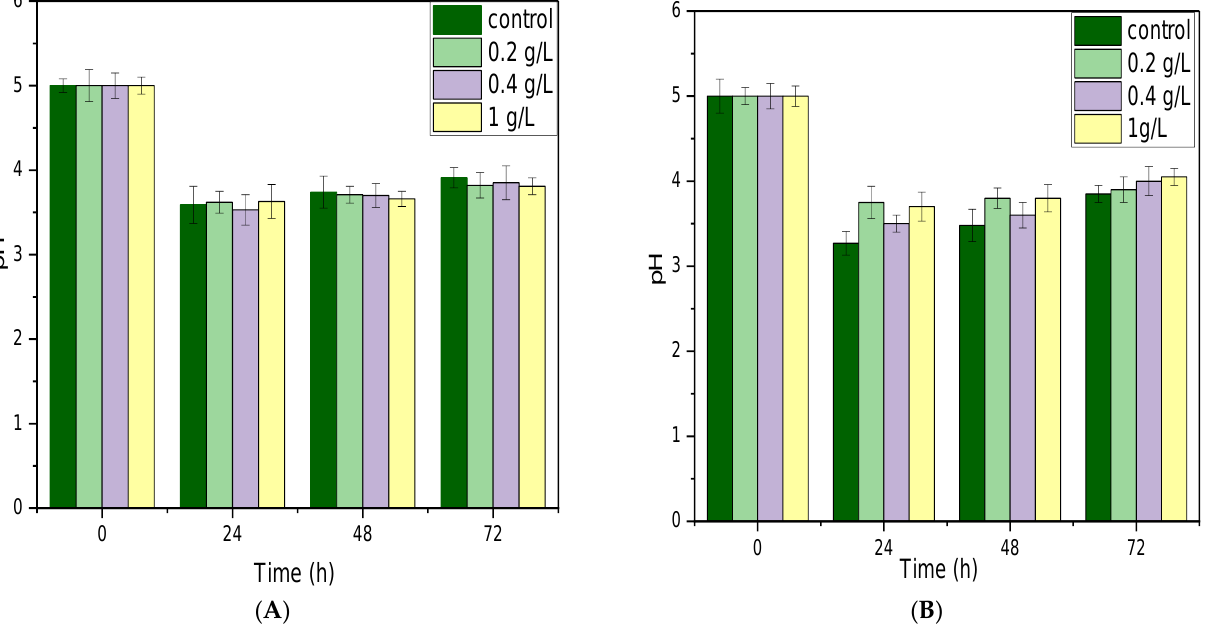
Figure 3. pH evolution during anaerobic fermentation: ( A ) effect of CaCl 2 and ( B ) effect of CaCO 3 .